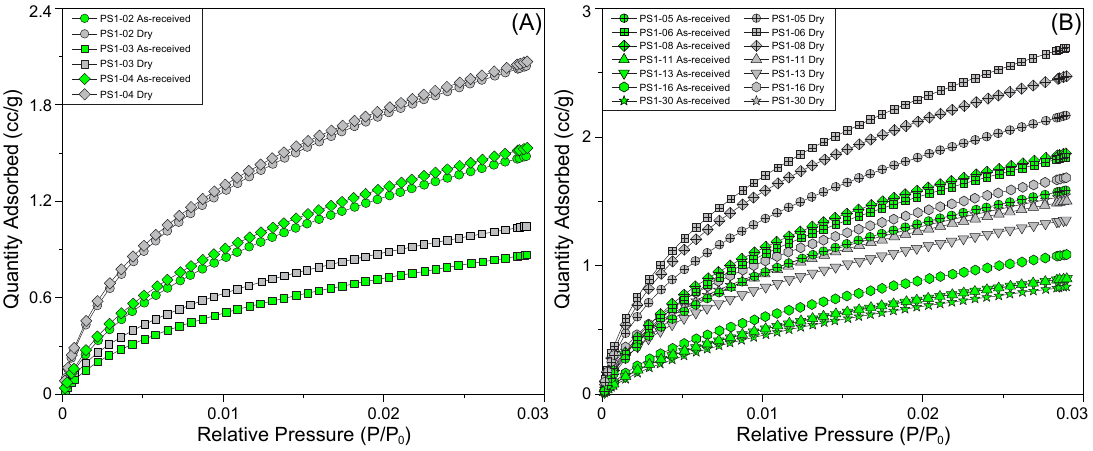
Figure 3. Low-pressure CO 2 adsorption isotherms of the as-received and dry shale samples from ( A ) the WF and ( B ) the LMX of the Well PS1. Table 2. Pore structure parameters (V mic , S mic , V n-mic , and S BET ) calculated from CO 2 and N 2 adsorptions of both as-received and dry shale samples from the Well